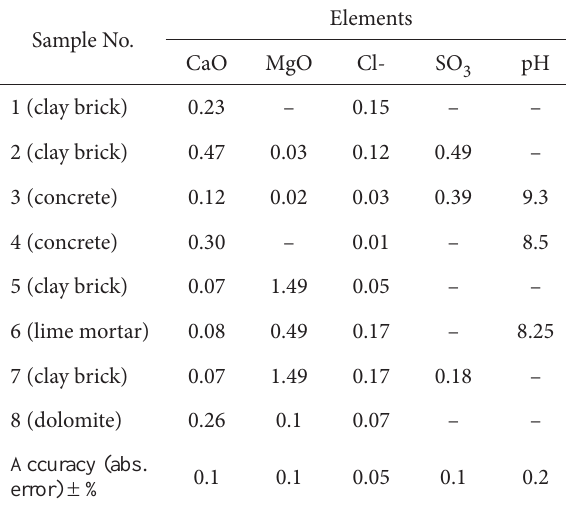
Table 4. Results of analysis of the salt saturation and pH level in samples Sample No.